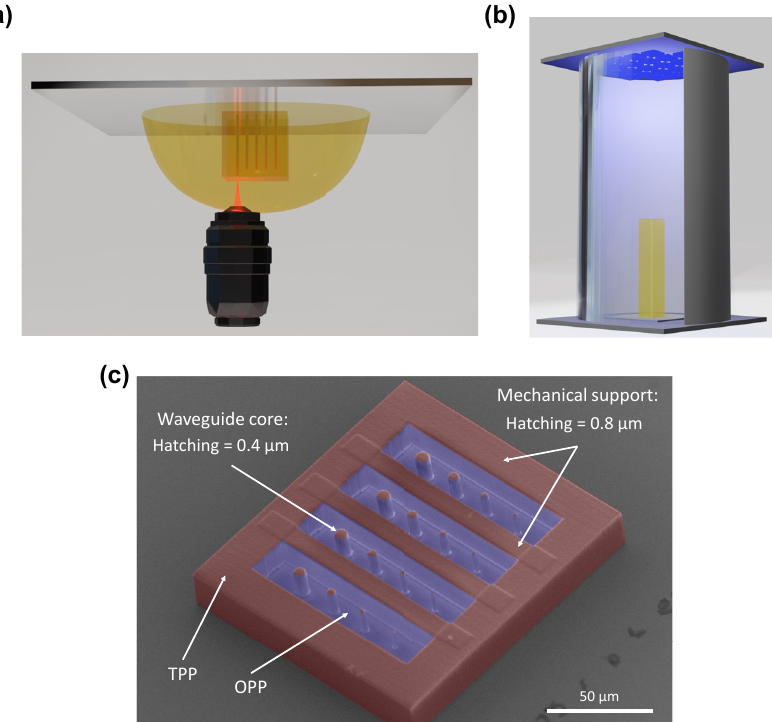
Figure 1: Flash -TPP for 3D integrated